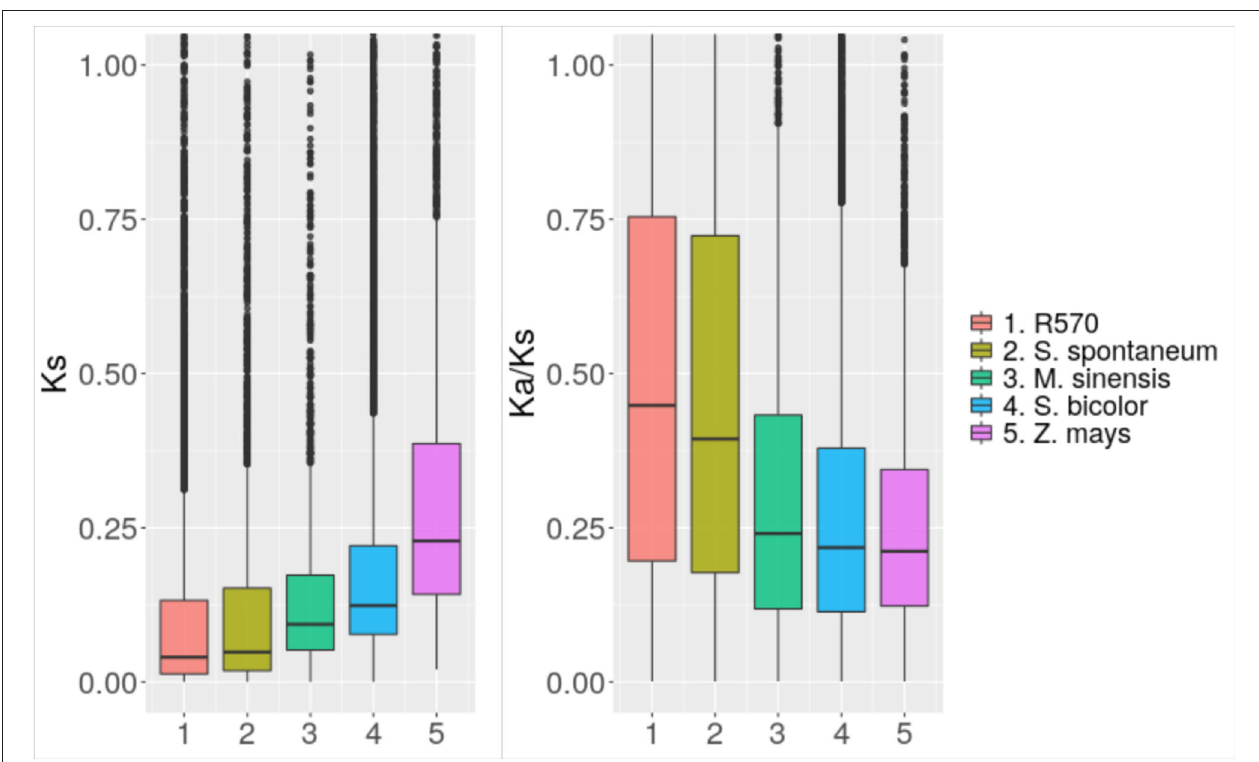
FIGURE 3 | Nucleotide evolution among close species. Distribution of the rate of synonymous mutations (Ks) and the ratio of synonymous to non-synonymous mutations (Ka/Ks) comparing genes annotated in the sugarcane genome assembled in this study with orthologs in the R570 assembly and assemblies of close